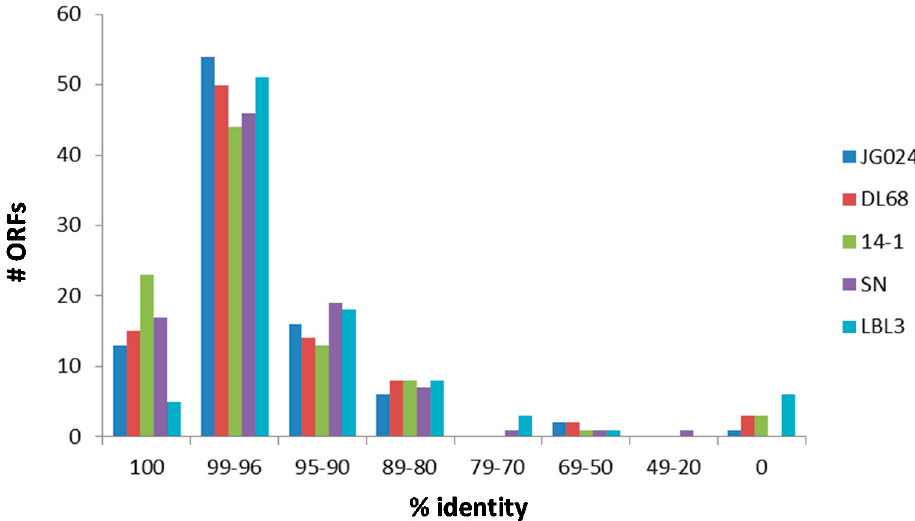
Figure 2. Sequence identity of translated ORFs of phage SL1 with five members of the PB1-like viruses (i.e., phages JG024, DL68, 14-1, SN, and LBL3).